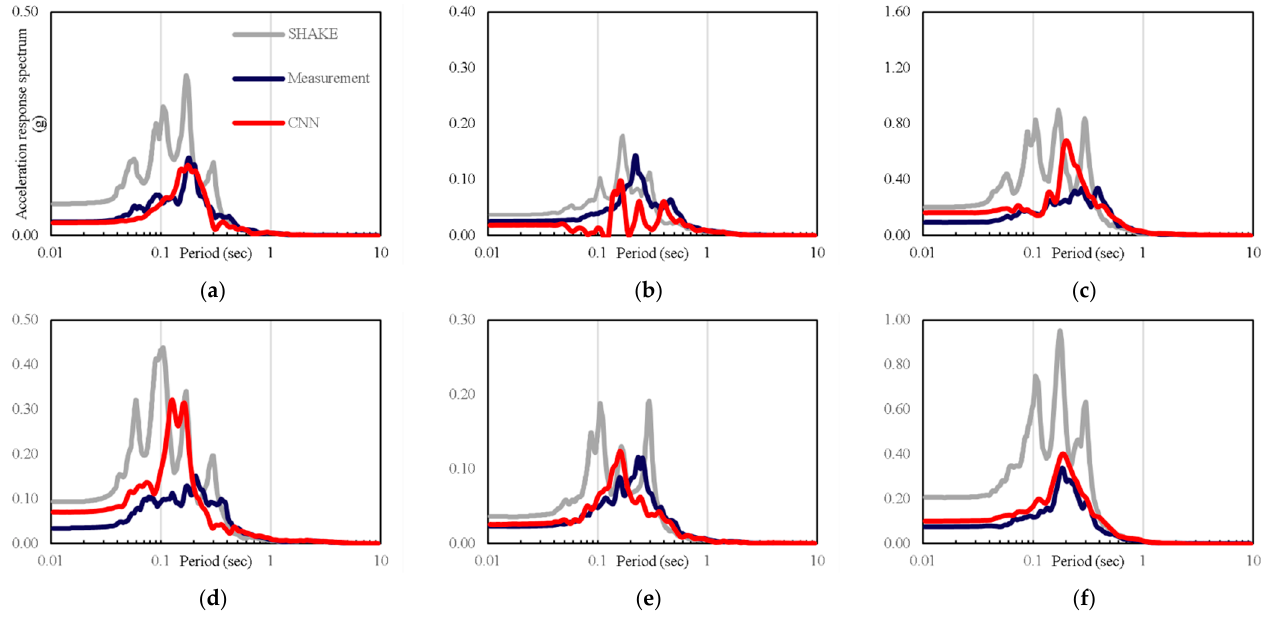
Figure 11. The six samples of acceleration response spectra measurements and predictions at site FKSH18. ( a ) FKSH181310260210.EW. ( b ) FKSH181407120422.NS. ( c ) FKSH181611220559.NS. ( d ) FKSH181612282138.NS. ( e ) FKSH181906182222.NS. ( f ) FKSH181908041923.EW.